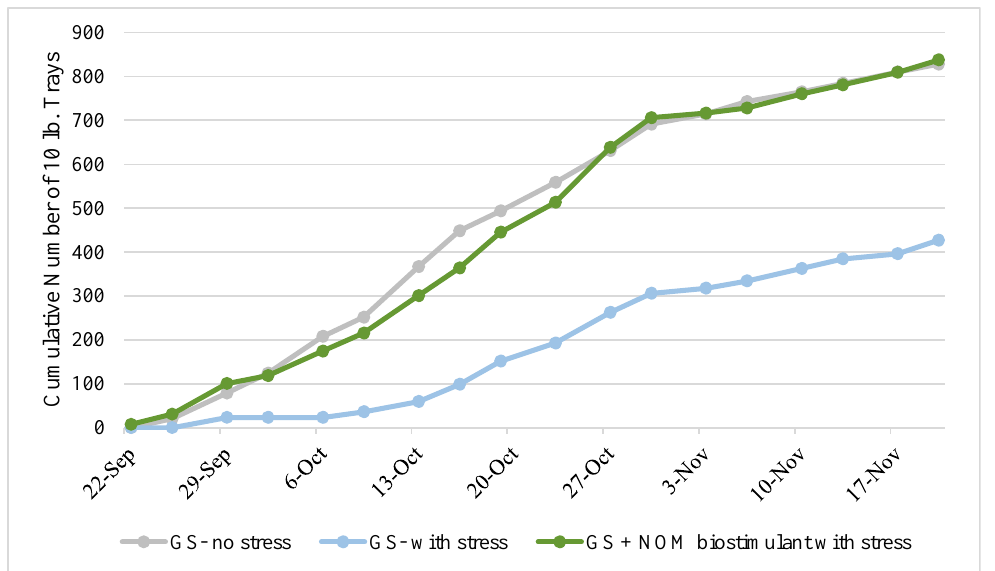
Figure 4. Cumulative strawberry yield by pick day during the salt stress trial for the grower standard (GS) non-stressed plants, GS stressed plants, and GS + NOM-based biostimulant treated stressed plants. The last of the 3 salt applications and the last of the 4 NOM biostimulant applications were done on 9/22.